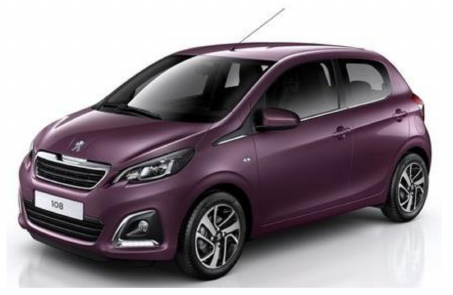
Figure 4. SMART four four.